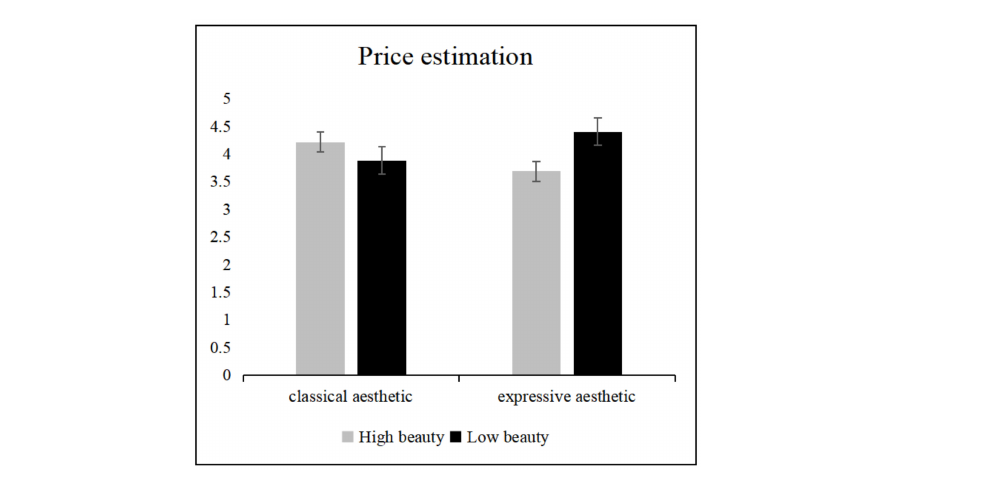
Figure 7. Price estimation for plates with different pattern types and different beauty levels. Error lines represent 95% confidence intervals.